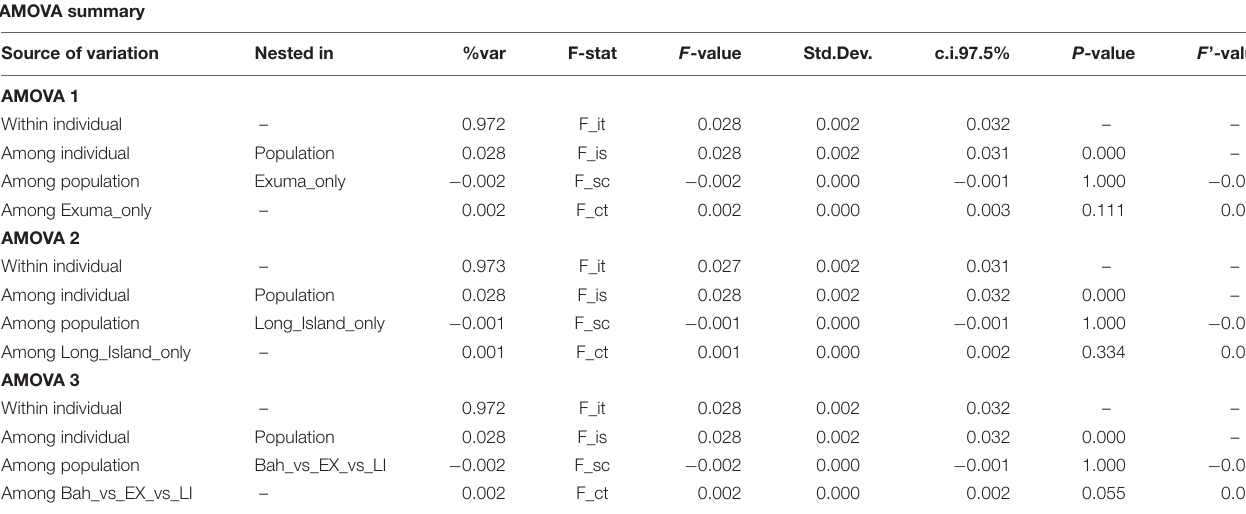
TABLE 2 | Analysis of Molecular Variance (AMOVA) for the three models tested to examine genetic variation in 94 Nassau grouper sampled from eight islands and one spawning site in The